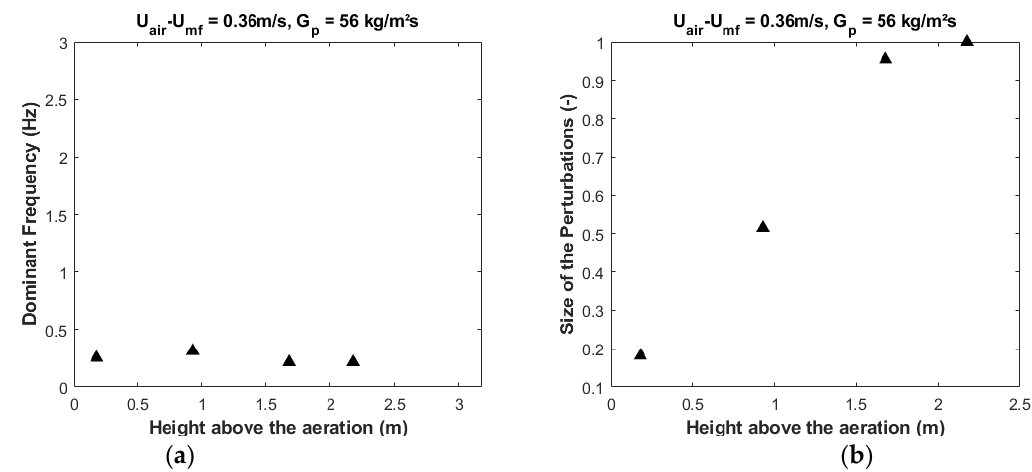
Figure 14. Evolutions with the height of ( a ) the dominant frequency of the IOP spectrum and ( b ) the integral of the IOP spectrum, for the same experimental configuration as for Figure 13.